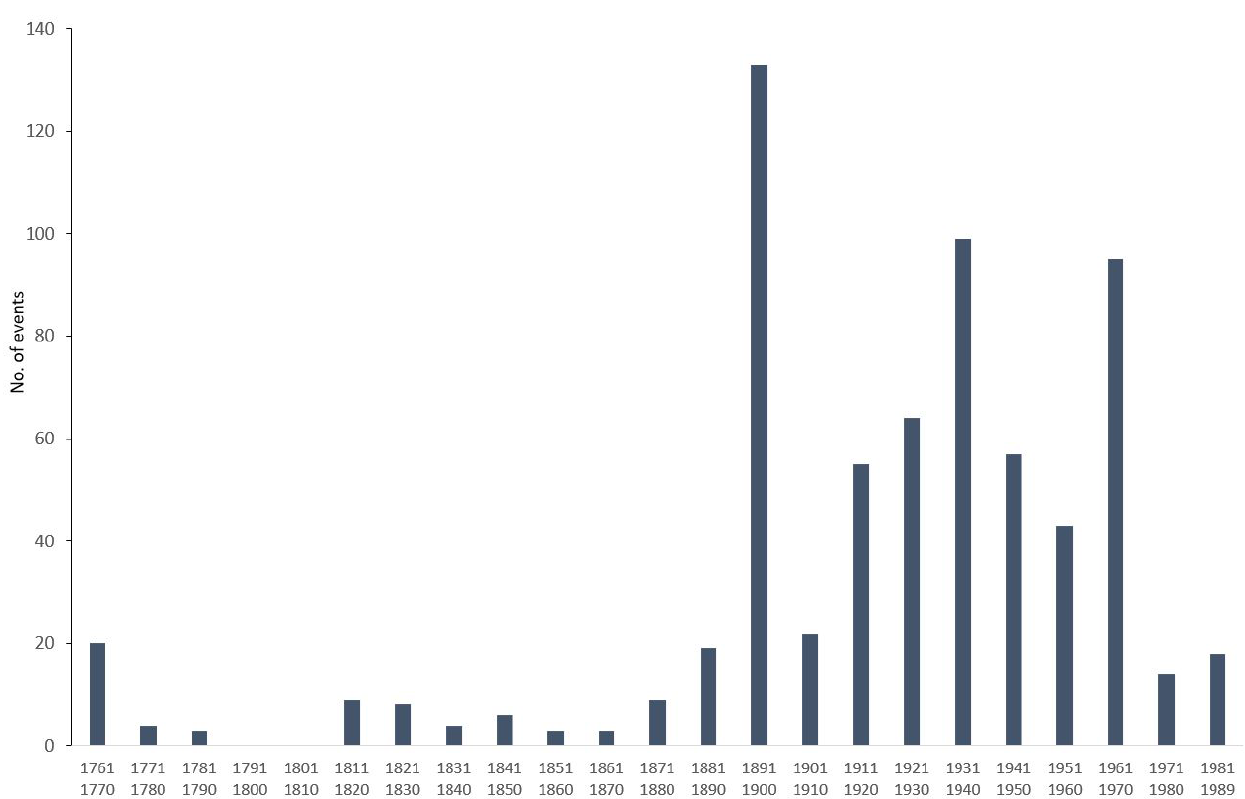
Figure 8. Decadal frequency of landslide records in Czechia between